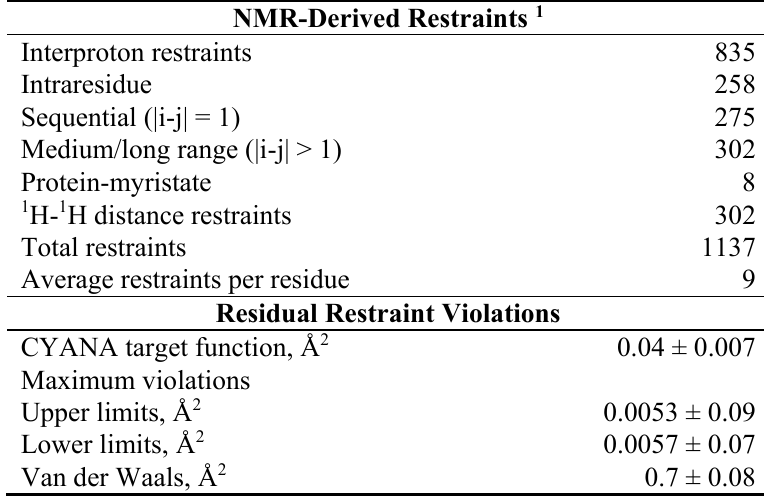
Table 1. Structure statistics for FIV MA Q5A/G6S